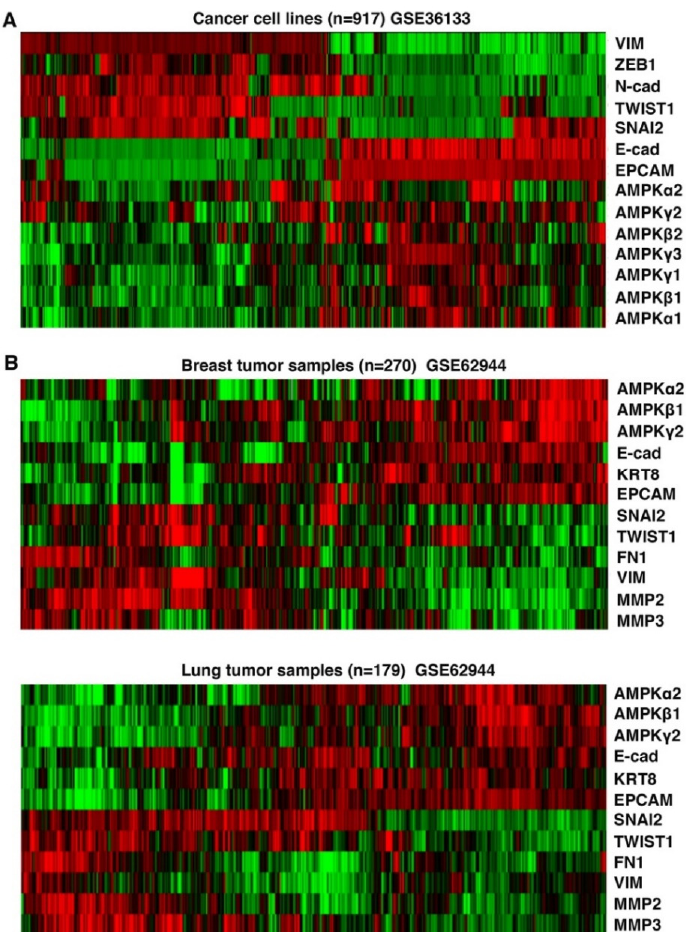
Figure 3. Correlation of AMPK gene expression with epithelial cell markers in human cancers. ( A ) Human cancer cell lines from the Cancer Cell Line Encyclopedia (CCLE) were clustered based on the expression levels of indicated AMPK genes, epithelial (E-cadherin and EPCAM) and mesenchy- mal (Vimentin, Zeb1, N-cadherin, Twist1, Snai2) markers. ( B ). Human breast and lung primary tu- mors were clustered based on expression levels of AMPK genes along with indicated epithelial